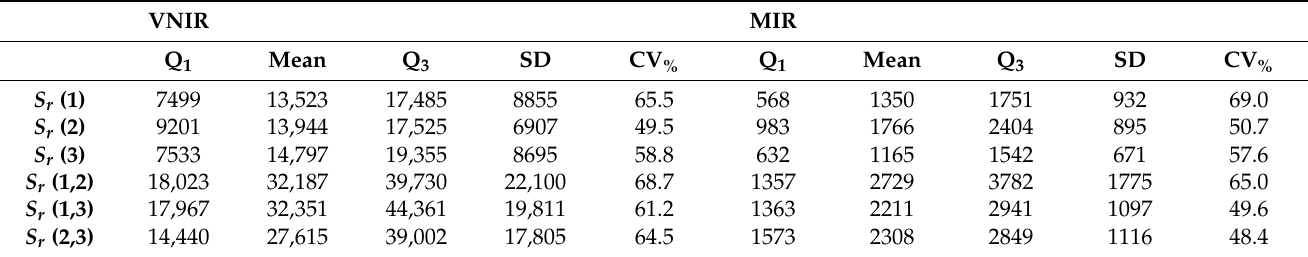
Table 4. Summary of spectral repeatability ( S r ) analysis for replicate VNIR and MIR